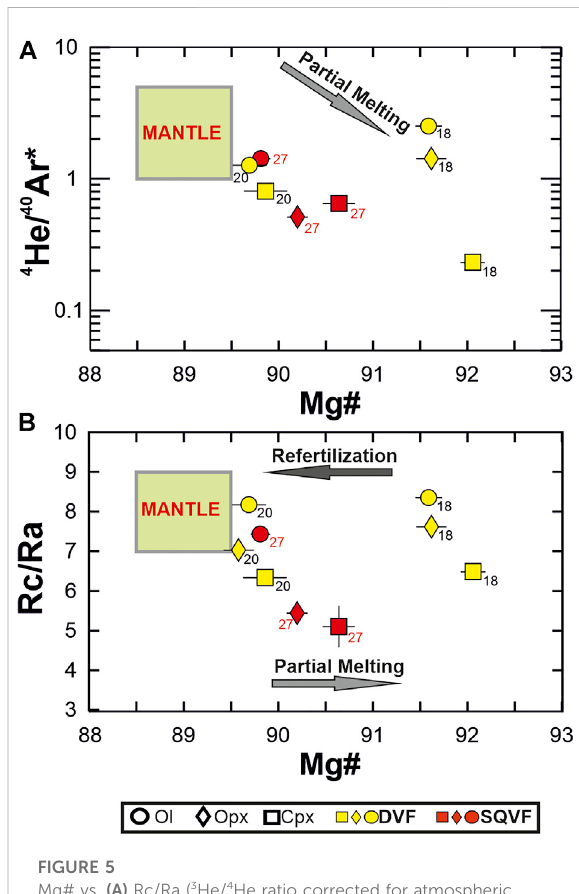
FIGURE 5 Mg# vs. (A) Rc/Ra ( 3 He/ 4 He ratio corrected for atmospheric contamination) and vs. (B) 4 He/ 40 Ar*. Mg# values were obtained from Luhr and Aranda-Gomez